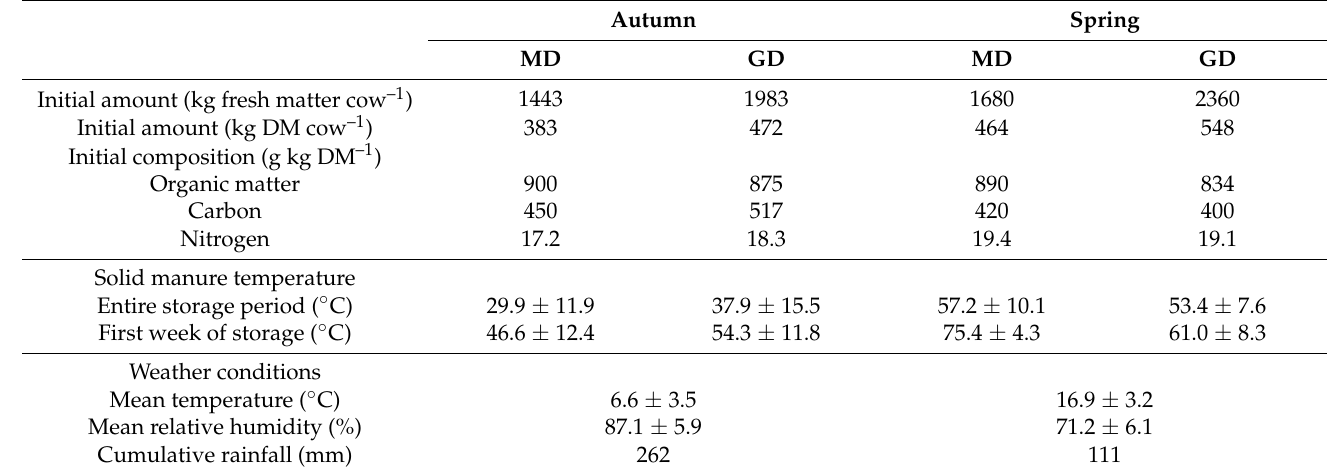
Table 3. Initial composition, solid manure temperature, and weather conditions (mean ± SD) during the storage phase of the straw-based deep litter produced by dairy cows fed with a maize-silage-based diet (MD) or a grass-based diet (GD) in autumn or spring.